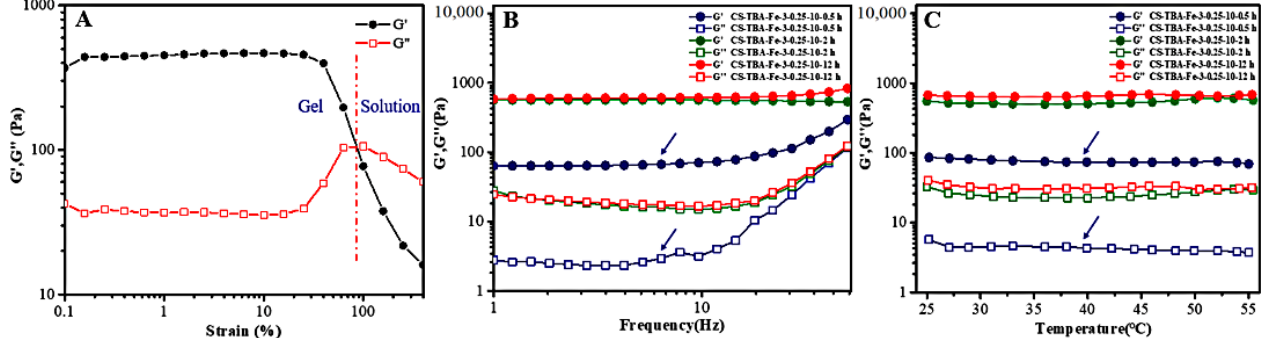
Figure 5. Linear viscoelastic region of CS-TBA-Fe hydrogels ( A ), and the frequency sweep ( B ) and temperature sweep (C ) tests with different curing time.